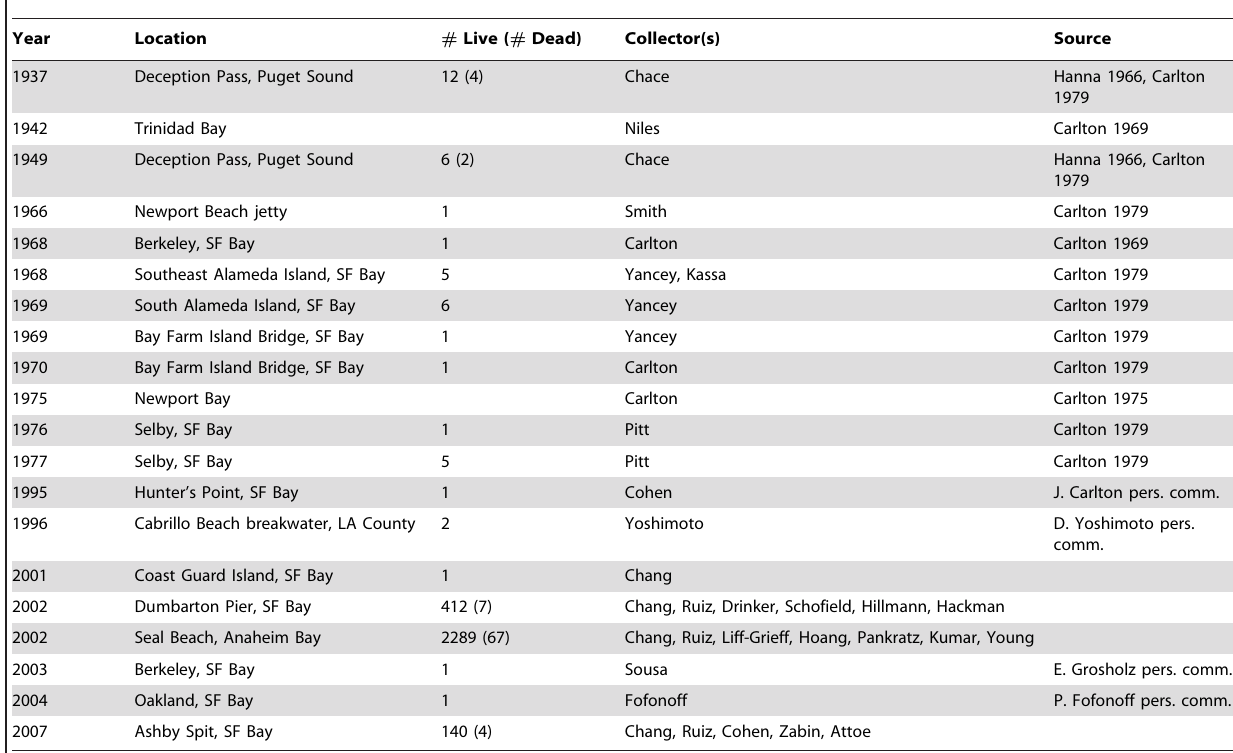
Table 1. Littorina littorea found on the Pacific Coast of North